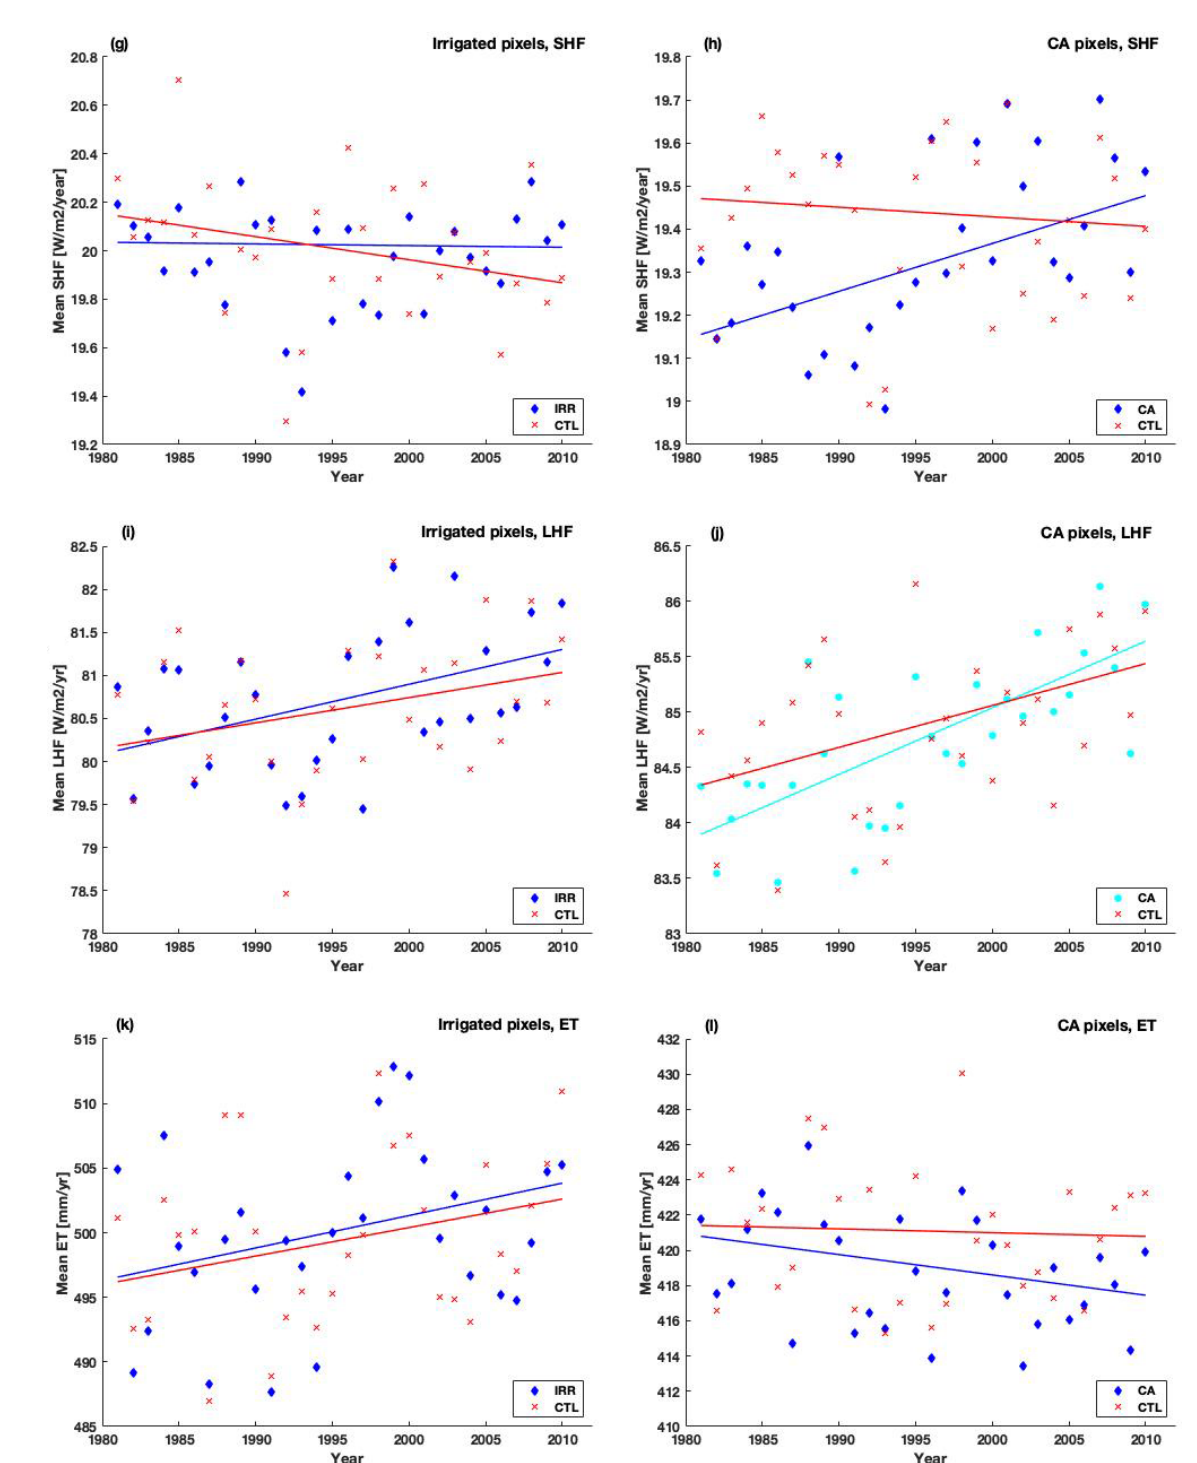
Figure 3. Spatial average of the warming rates for T 2 m (a, c, e) , TXx (b, d, f) , SHF (g, h) , LHF (i, j) and ET (k, l) for the CESM ensembles and observations. Data points specify the mean T 2 m and TXx temperatures, SHF, LHF and ET volumes for irrigated pixels (a, b, g, i, k) , CA pixels (c, d, h, j, l) and (e–f) all land pixels. The slope was estimated using Sen’s slope for the CTL (red), IRR (blue), CA (cyan), CRU (purple), HadEX2 (yellow) and GHCNDEX (black) temperatures.